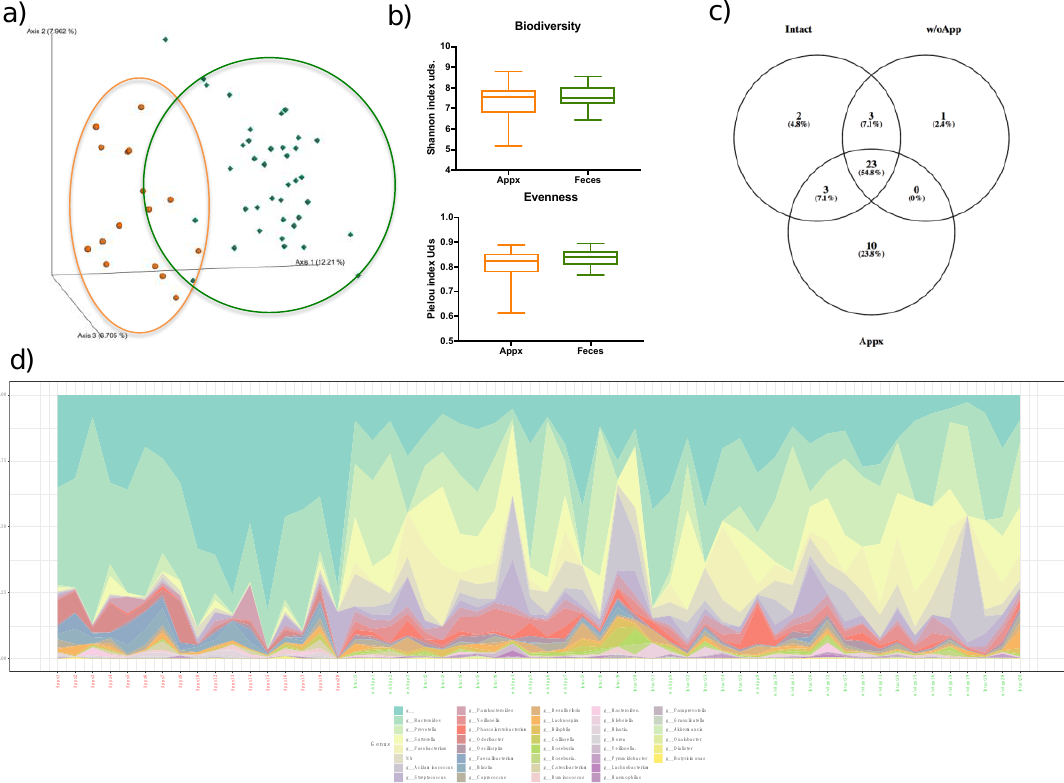
Figure 2. ( a ) Clustering of bacterial communities of the appendix (orange dots) or fecal samples (green diamonds) by principal coordinate analysis (PCoA) using the weighted UniFrac distances. ( b ) Alpha diversity indexes of appendix and fecal samples. ( c ) Venn diagram of the microbiota profiles at family level of the analyzed fecal samples of the w / oApp and Intact groups as well as the appendix tissues. ( d ) Microbiota profiles at genus level of the appendix and fecal